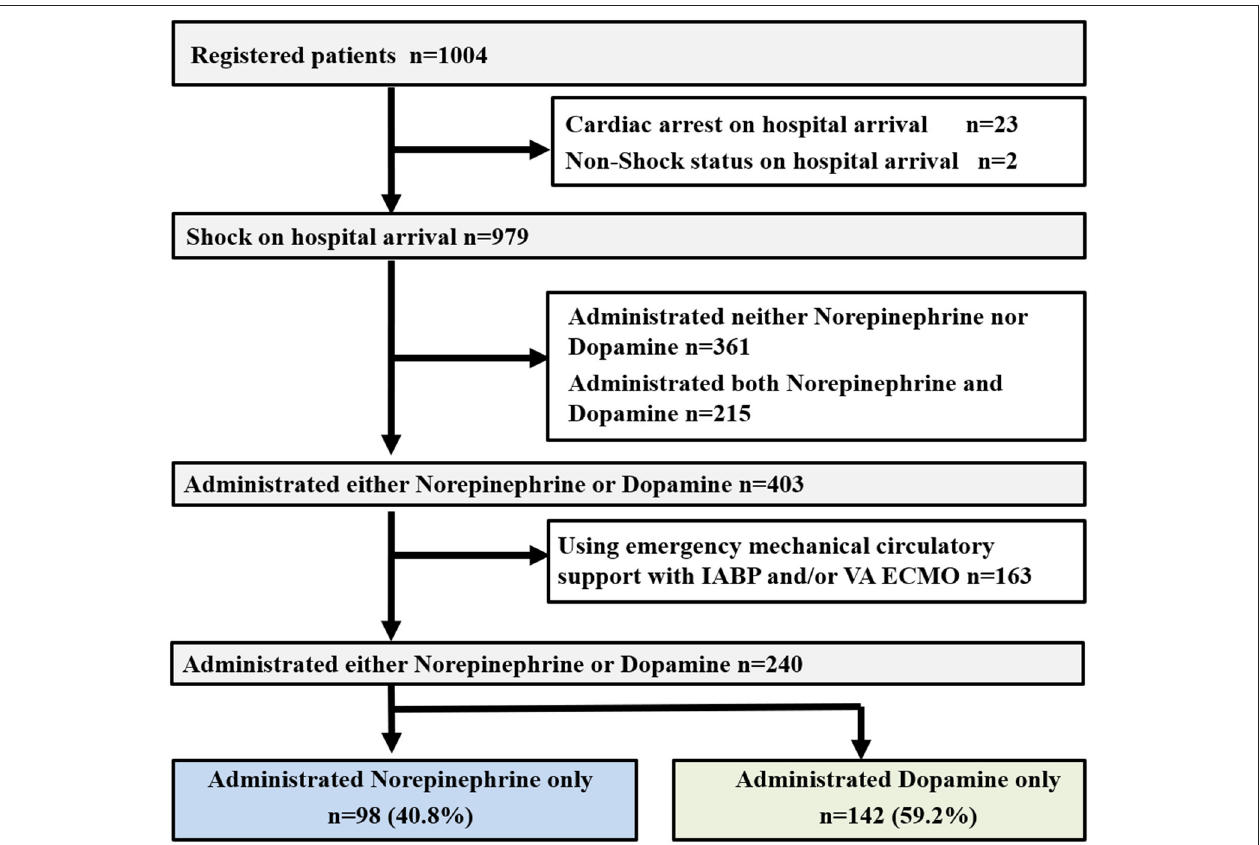
FIGURE 1 | Study profile. OHCA, out-of-hospital cardiac arrest; ROSC, return of spontaneous circulation; IABP, intra-aortic balloon pumping; VA ECMO, veno-arterial extracorporeal membrane oxygenation.